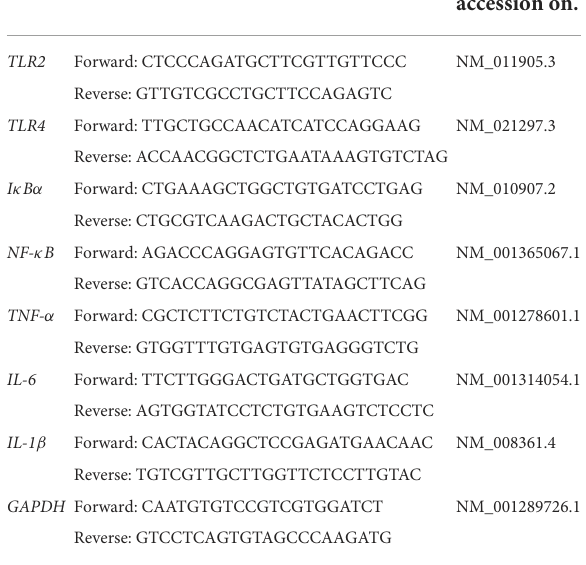
TABLE 1 The primers for